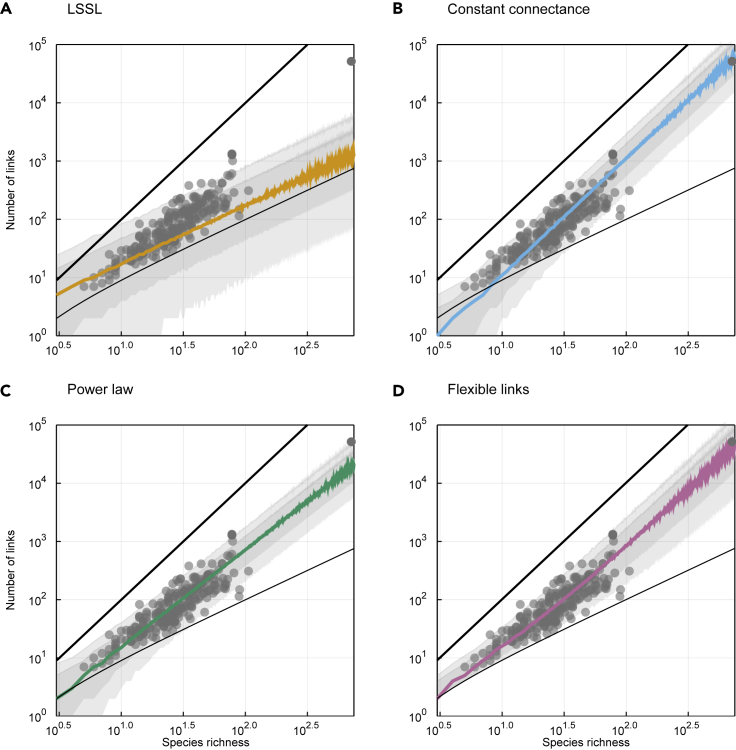
The Flexible Links Model Fits Better and Makes a Plausible Range of PredictionsThe number of links is plotted as a function of species richness obtained from the posterior distributions of (A) the link-species scaling, (B) the constant connectance, (C) the power law, and (D) the flexible links models. In each panel, the colored line represents the median predicted link number and the gray areas cover the 78% and 97% percentile intervals. Empirical data from the mangal.io database are plotted in each panel (gray dots), as well as the minimal S − 1 and maximal S2 number of links (thinner and bolder black lines, respectively). Predictions from the flexible links model are always plausible: they stay within these biological boundaries.